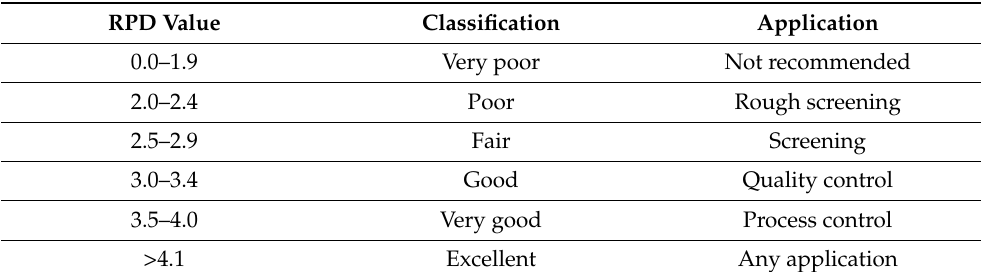
Table 4. Levels of merit for the ratio of the performance deviation (RPD) for the application of NIR spectroscopy